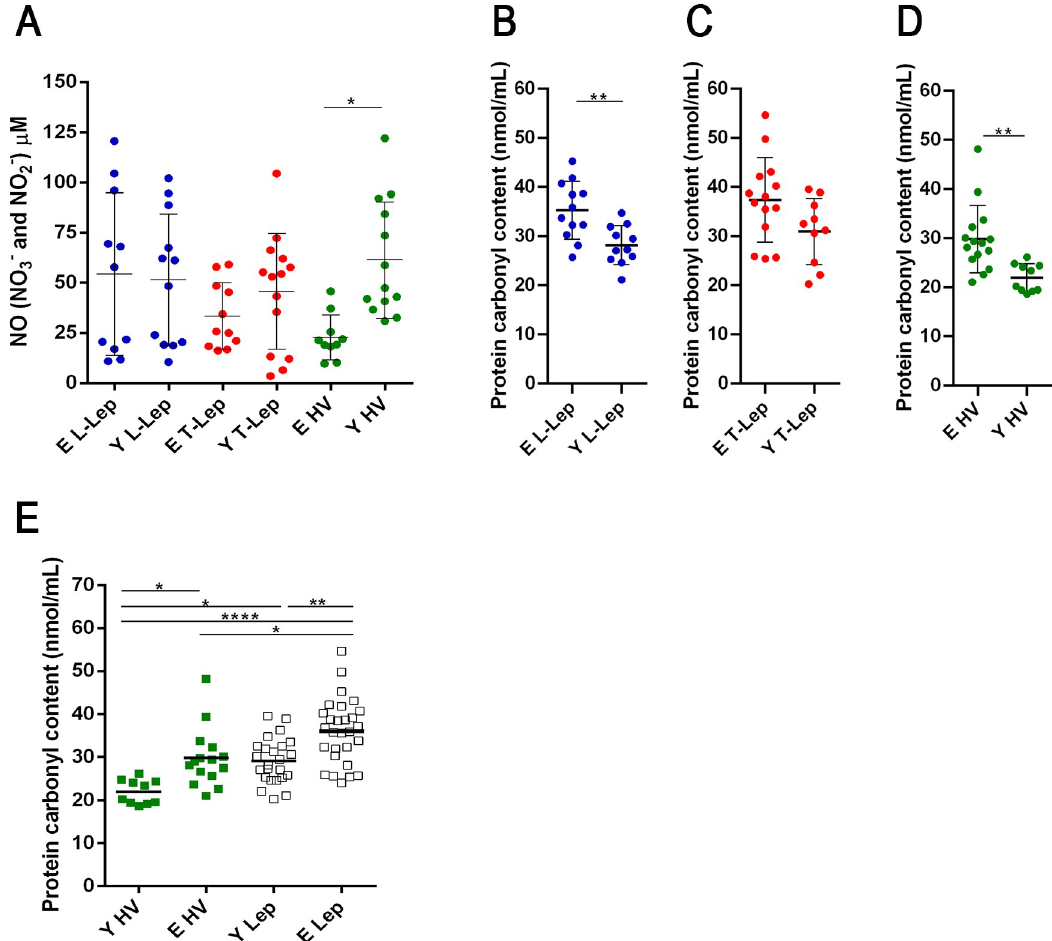
Fig 1. Evaluation of oxidative stress in serum samples. (A) Concentration of NO in the serum of patients and healthy volunteers. Horizontal short lines represent mean of each group. Analysis of variance was performed by one-way ANOVA followed by Tukey’s multiple comparison test. Graphs represent means ± SD of serum protein carbonyl group concentration and a Mann/Whitney U- test for continuous variables was performed to evaluate significant differences between groups of (B) L-Lep patients (Y n = 12 and E n = 13), (C) T-Lep patients (Y n = 12 and E n = 15) and (D) healthy volunteers (Y n = 10 and E n = 15), each circle represents an individual. (E) Serum protein carbonyl group concentration, each square represents an individual (same n above) and the short horizontal lines represent means. Analysis was performed by one-way ANOVA followed by Tukey’s multiple comparison test. � P < 0.05, �� P < 0.01 and ���� P = 0.0001. Abbreviations: E—Elderly; Y—Young; T-Lep (paucibacillary; TT/BT patients); L-Lep (multibacillary; BL/LL patients); HV—healthy